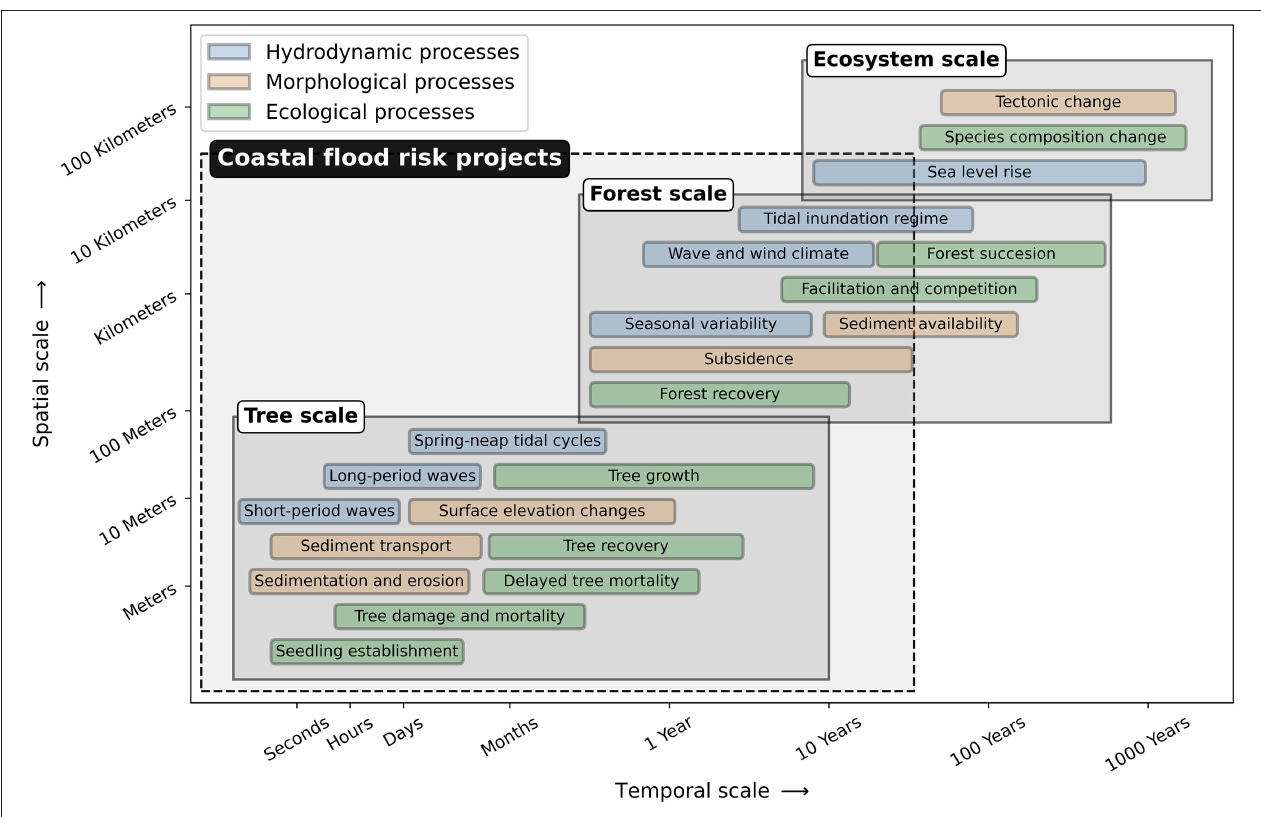
FIGURE 4 | Spatial and temporal scales of interacting hydrodynamic, morphological and ecological processes in mangroves. A distinction is made between the most important processes that shape (1) trees and tree patches—tree scale, (2) forests along an elevation gradient—forest scale and (3) entire mangrove ecosystems—ecosystem scale. The spatial and temporal scale of coastal flood risk projects typically comprises the tree scale and forest